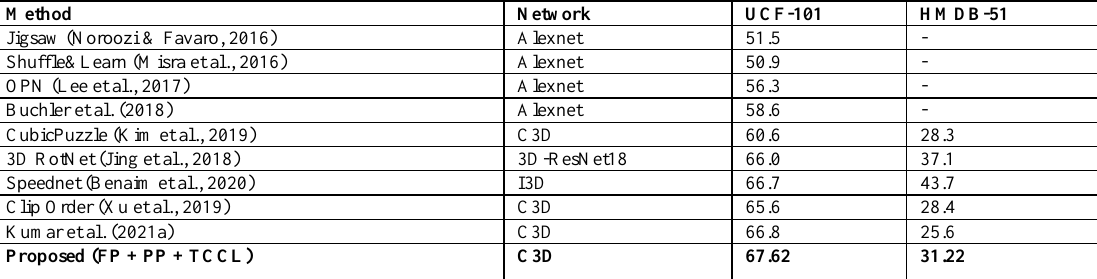
Table 6. Action recognition